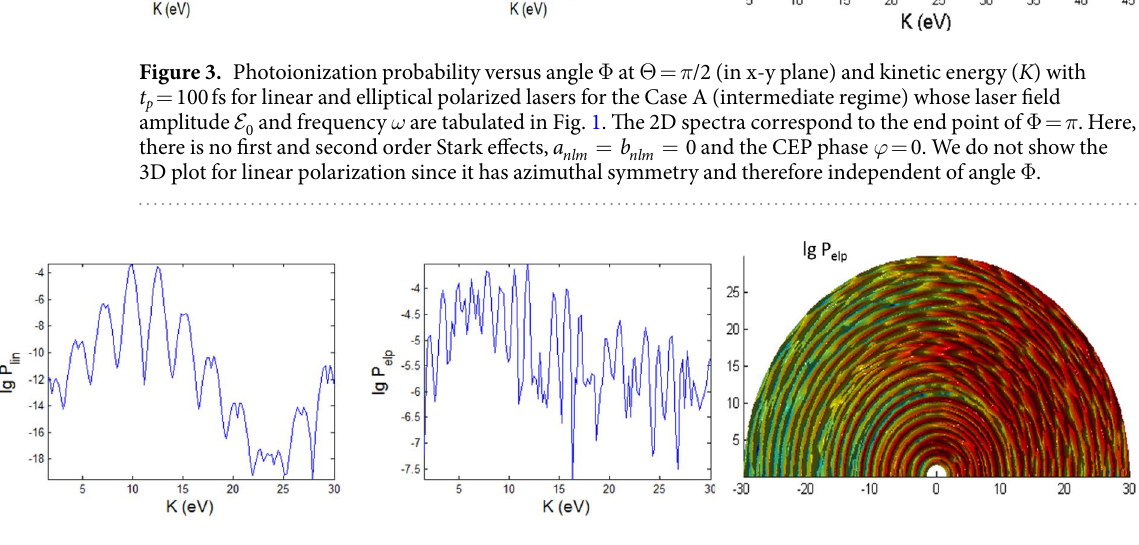
Figure 4. Same as Fig. 3 (versus angle Φ with t p = 100 fs) but for case B.